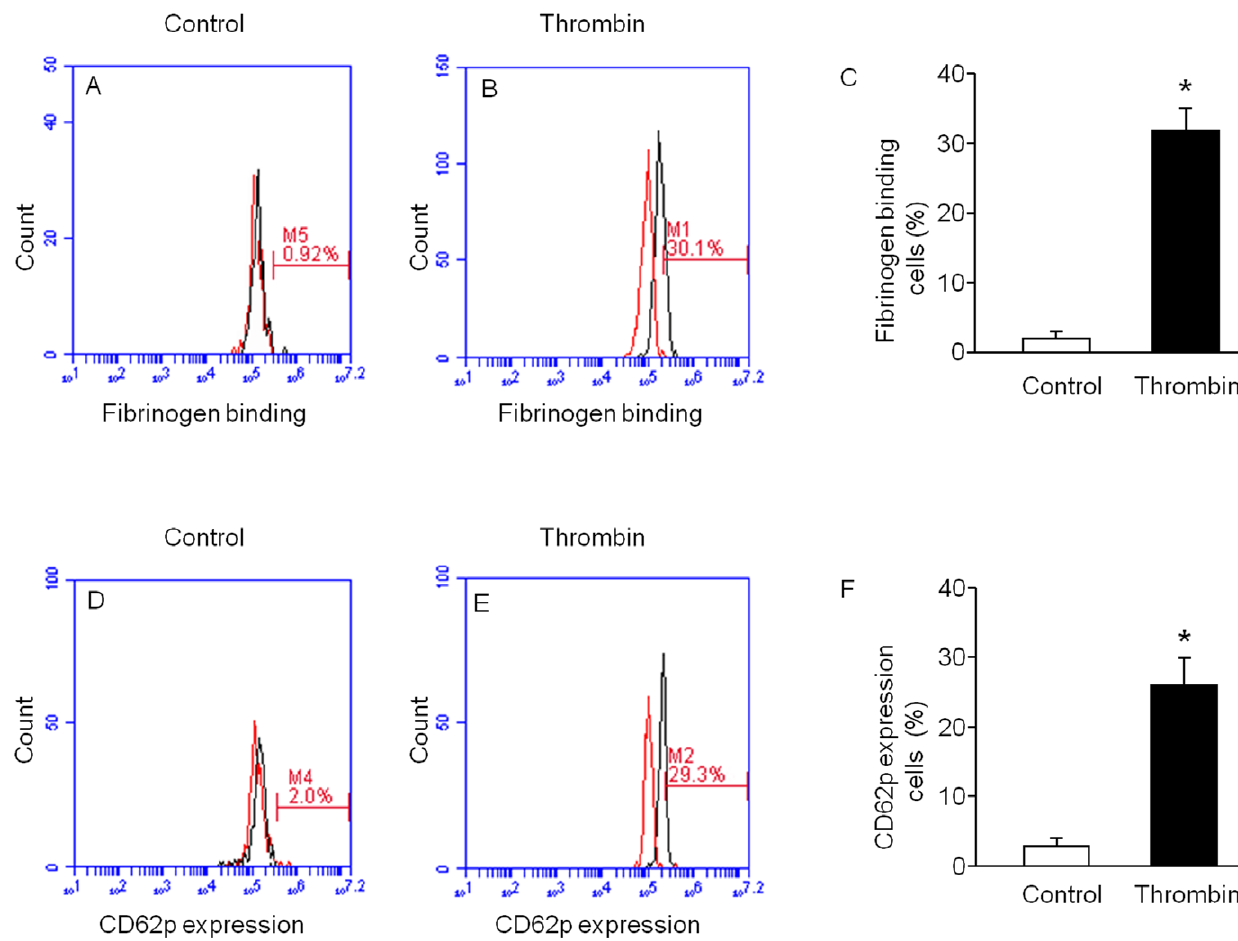
Figure 6. Functional assay of PLTs released from generated MKs. Thrombin stimulation raised fibrinogen binding and CD62p expression in PLTs released from the generated MKs. Representative flow cytometric plots (A, B: fibrinogen binding; D, E: CD62p. left curves, isotype controls; right curves, antibodies). Summarized data show fibrinogen binding (C) and CD62p expression (F) in PLTs after thrombin stimulation. Data are expressed as mean 6 SEM, * P , 0.01, control versus stimulation, n=4/group.